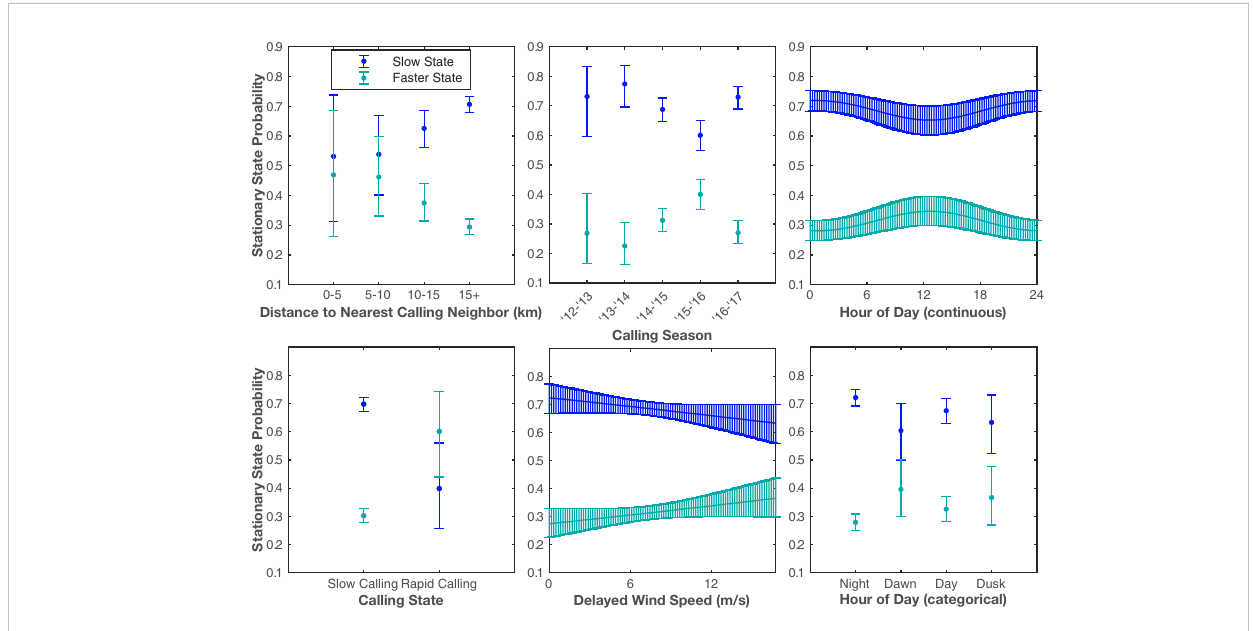
FIGURE 7 The probability of a 5 min observation being in the Slow State or the Faster State based on the independent variable tested. The blue and teal curves show the stationary state probabilities of the Slow State and the Faster State, respectively. The error bounds show the 95% con fi dence intervals.